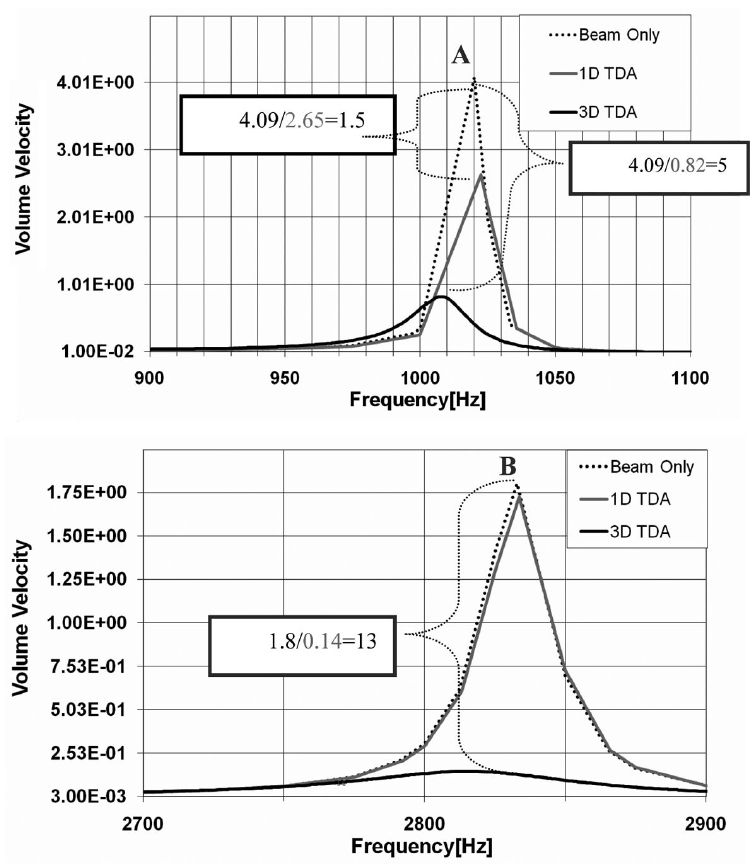
Fig. 13. Close-up view of the two resonance peaks from Fig. 12 Upper figure – Peak A, Lower figure – Peak B.